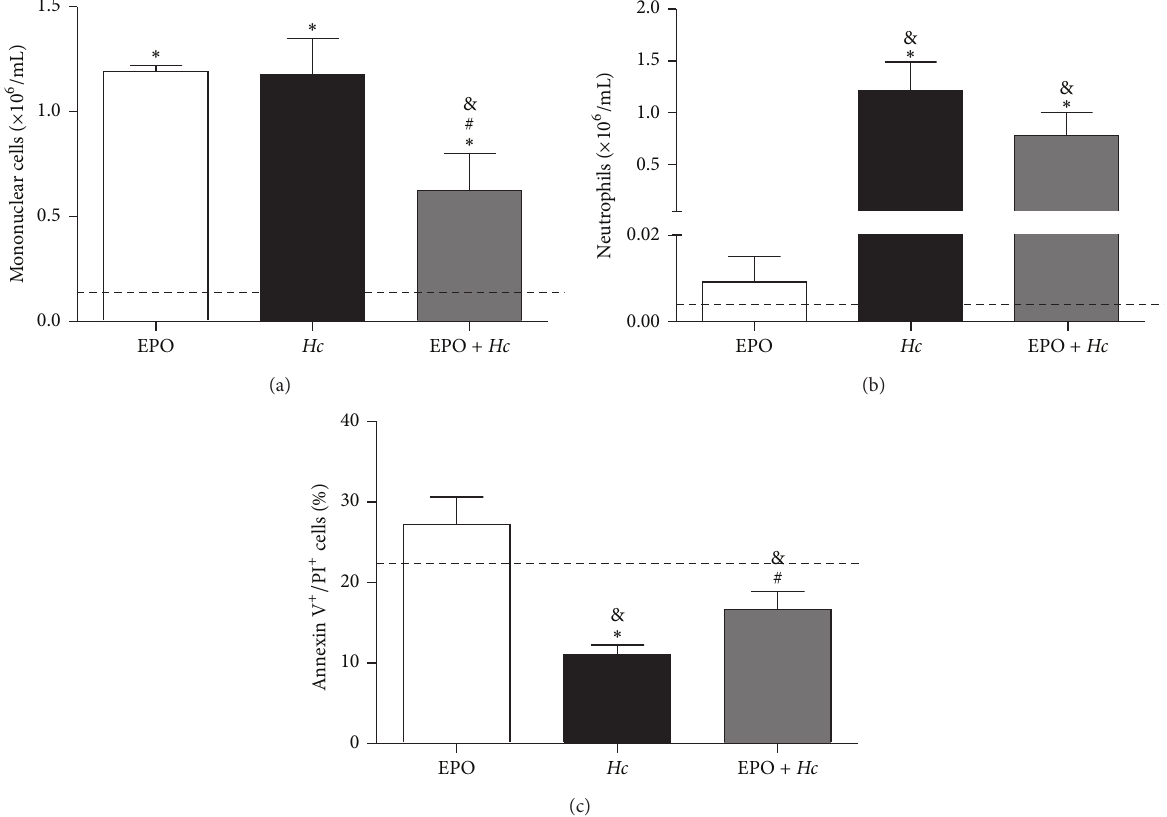
Figure 3: EPO pretreatment decreases the number of mononuclear cells and increases the number of cells in late apoptosis in BALF samples of Hc -infected mice. 14 days after infection, BALF from uninfected mice treated with 45 U of EPO (EPO) and from untreated ( Hc ) or EPO pretreated ( EPO + Hc ) mice infected with Hc (5 × 10 5 yeasts/100 𝜇 L/mouse) were evaluated for numbers of (a) mononuclear cells and (b) neutrophils.(c)Flowcytometryusingannexin/PIstainingwasusedtodetectlateapoptoticcells(annexin + /PI + ).((a)and(b))Valuesrepresent means ± SEM and (c) means ± SD of one representative of two independent experiments ( 𝑛 = 4 –6). Newman-Keuls multiple comparison test was used and the differences were considered significant when 𝑝 < 0.05 . # Versus Hc ; ∗ versus uninfected and EPO-untreated (dashed line); & versus uninfected and EPO-treated